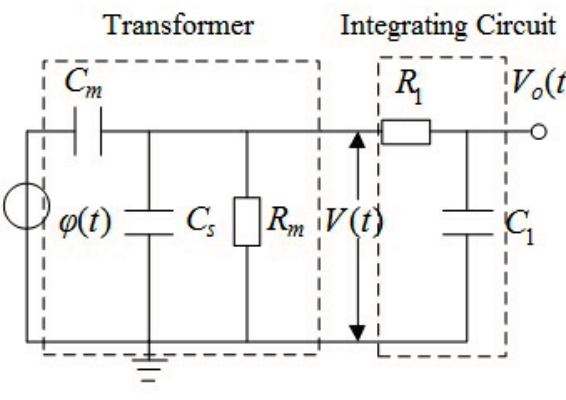
Figure 5. Equivalent circuit of the probe and passive